Question: Write the caption for this figure.
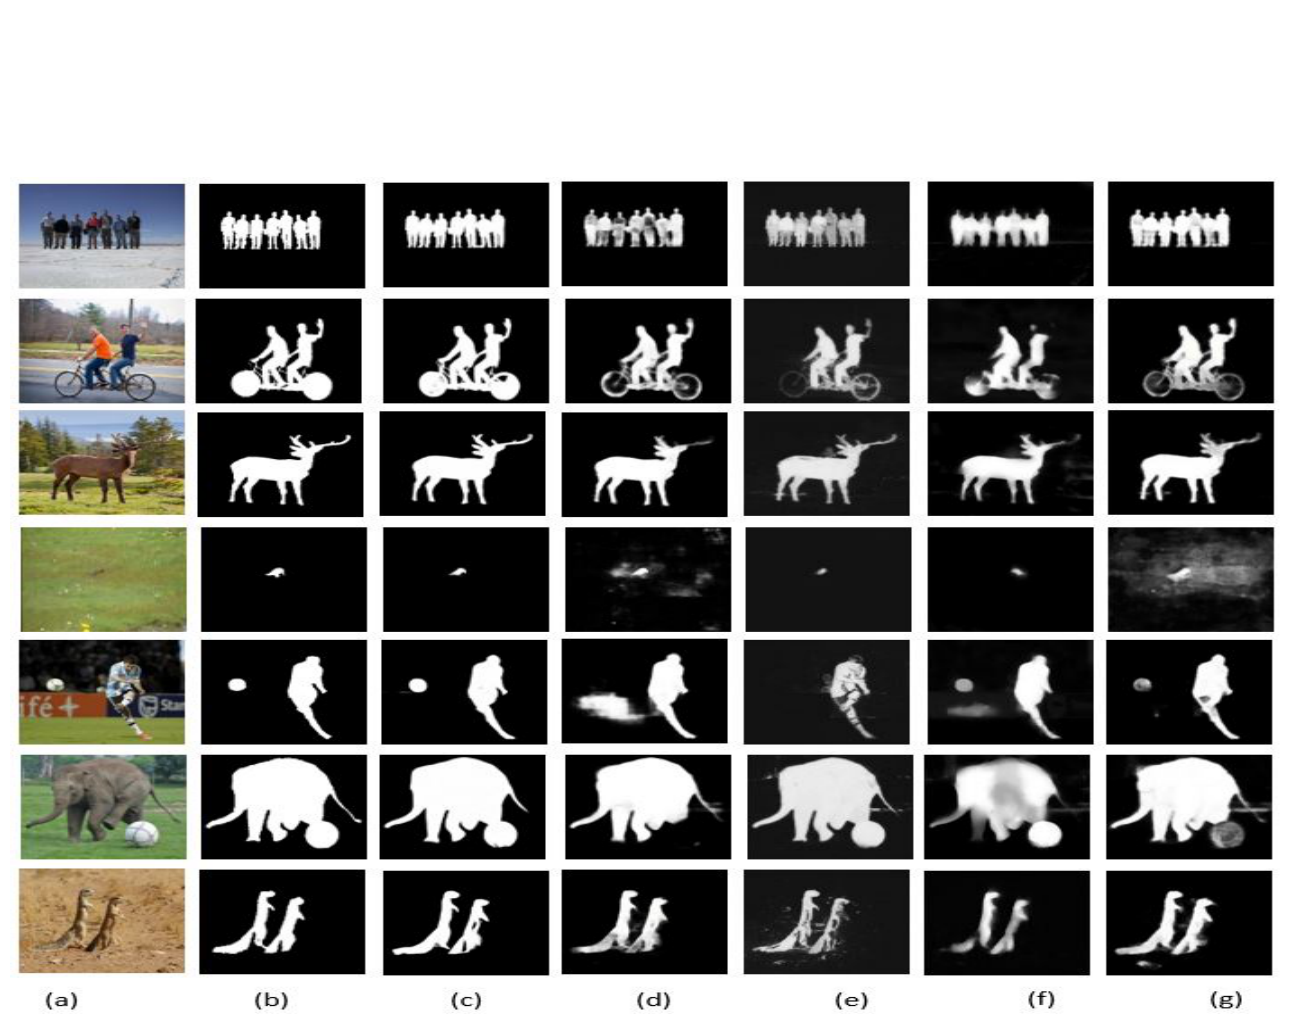
Answer: Qualitative comparison of the proposed method with four other SOTA methods: (a) original image, (b) GT, (c) Ours, (d) Amulet, (e) DCL, (f) RFCN, (g) UCF